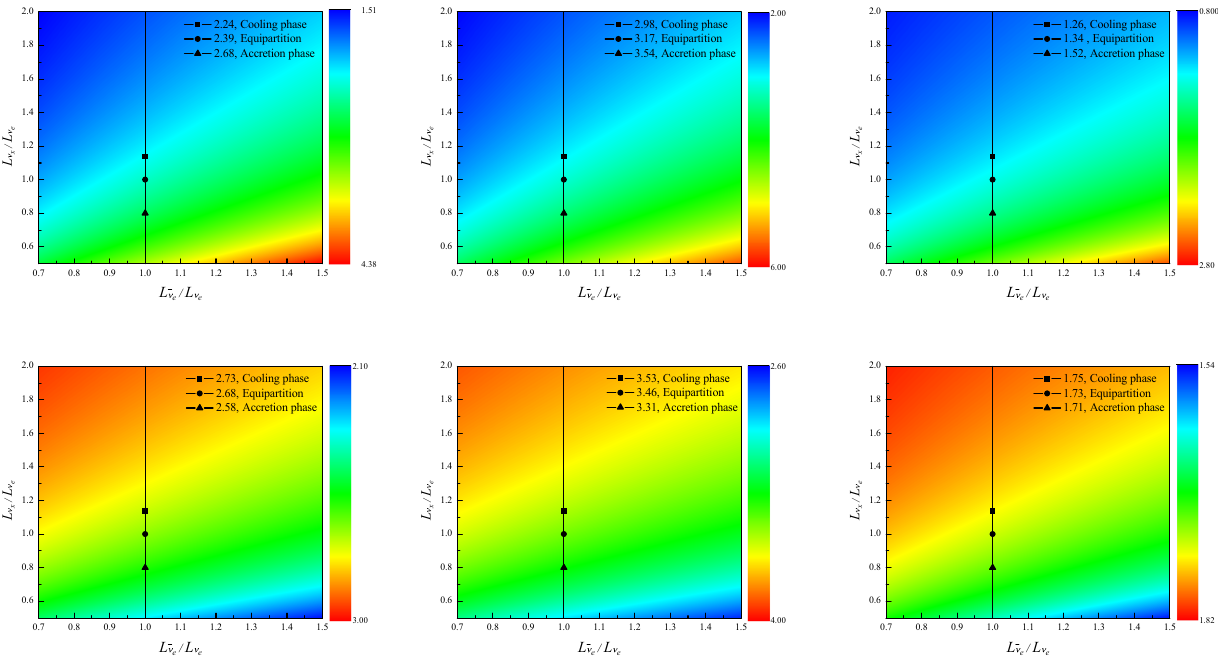
Fig. 1 Ratios R of IBD events to NC events in JUNO for different energy compositions in ν e , ¯ ν e , and ν x for the normal mass hierarchy on the upper panel and for the inverted mass hierarchy on the lower panel. From left to right, the three columns correspond to three different sets